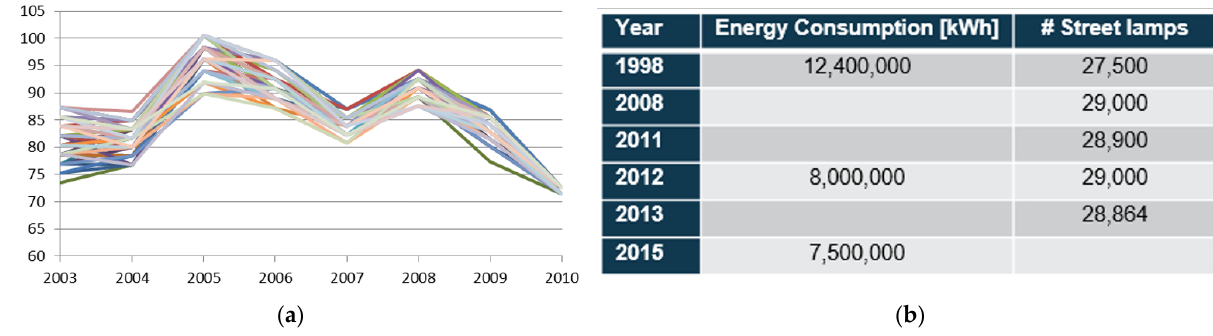
Figure A5. Decreases in nightlight intensity within urban areas where each different colored line represents an individual pixel ( a ) corresponding with improved energy efficiency based on data collected by the City of Krefeld Energy Conservation Program ( b ).